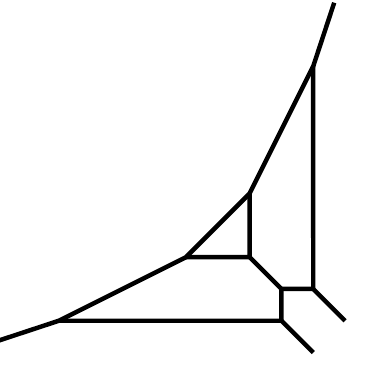
Figure 22 . A 5-brane web diagram corresponding to the orbifold C 3 = (cid:0) with the orbifold ac- tion